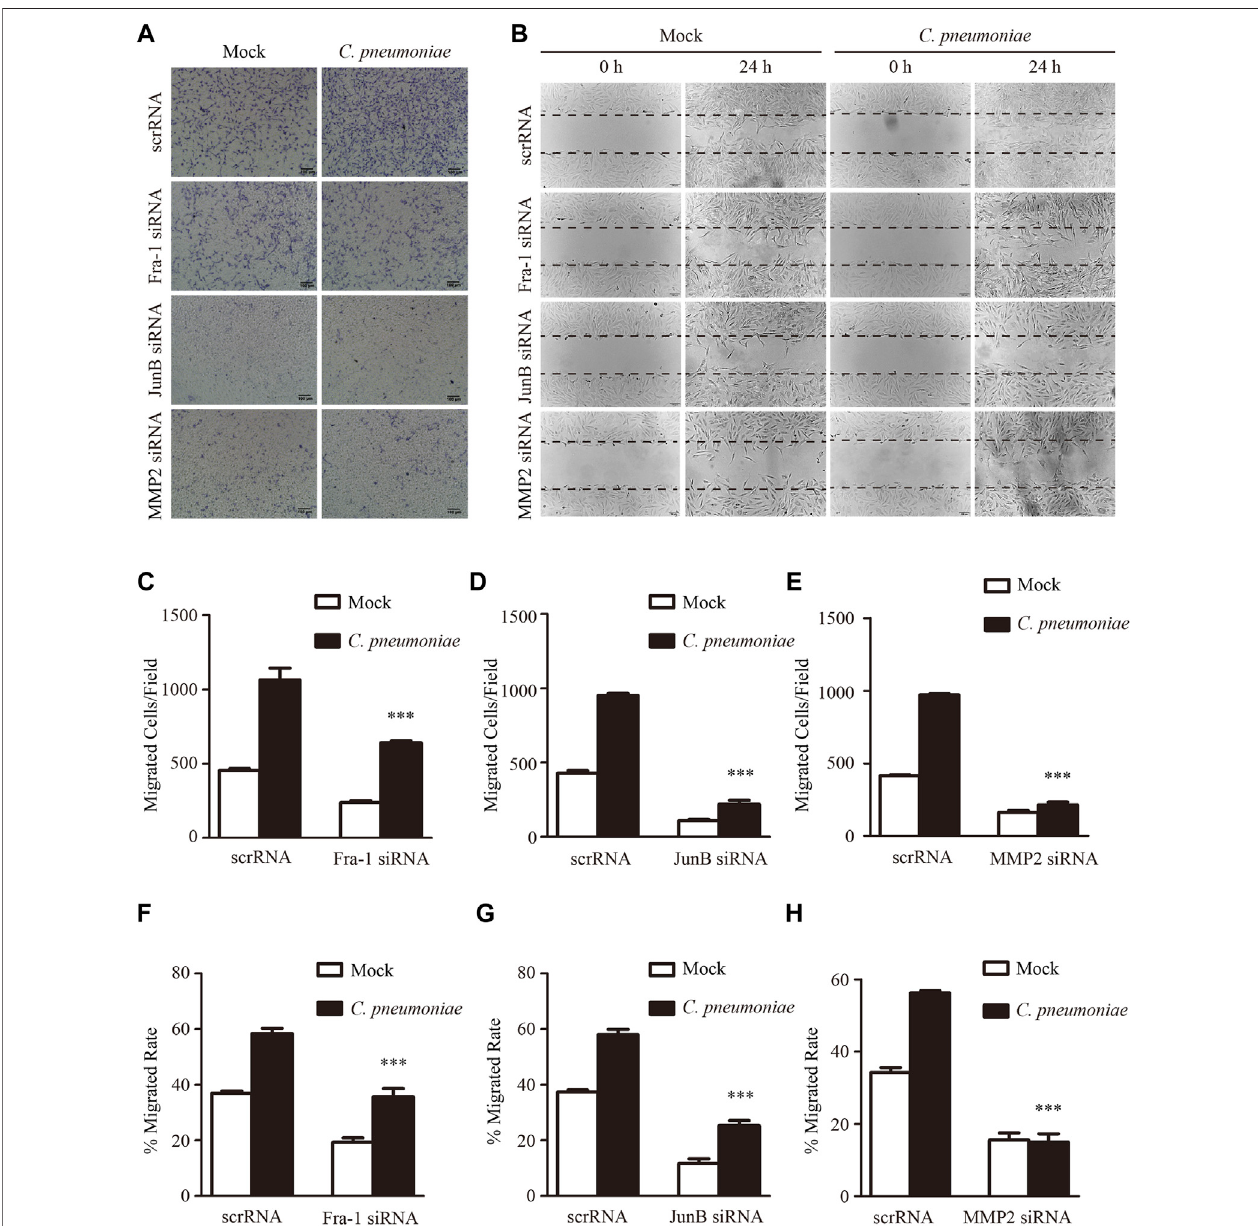
FIGURE 5 | C. pneumoniae infection induces VSMC migration through Fra-1, JunB and MMP2. (A,B) Representative images of Transwell assays (A) and wound healingassays (B) for C.pneumoniae infection-inducedmigrationofVSMCspretreatedwithFra-1speci fi csmallinterferingRNA(siRNA)orJunBspeci fi csiRNAorMMP2 speci fi c siRNA or scrRNA. (C – E) The quantitative results for migrated VSMCs/ fi eld pretreated with the indicated speci fi c siRNA. *** p < 0.001, compared with scramble siRNA (scrRNA) and C. pneumoniae infection group, asanalyzed by Student ’ s t -test. (F – H) The quantitative results forthearea ofwoundclosure weredetectedat 24 h after scratch. VSMCs were pretreated with the indicated speci fi c siRNA. *** p < 0.001, compared with scrRNA and C. pneumoniae infection group, as analyzed by Student ’ s t -test.